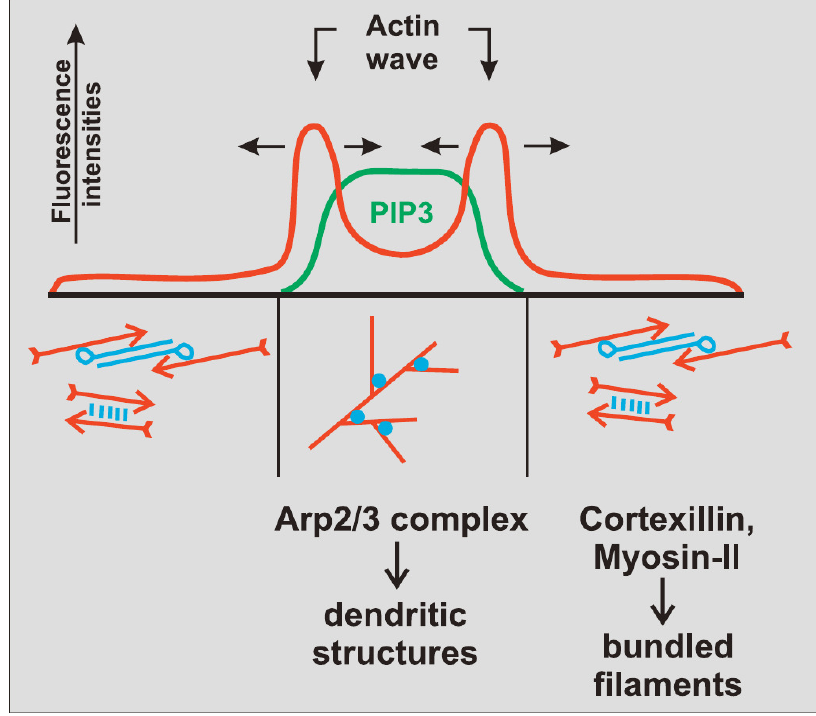
Figure 7. A cross-section of the waves in LatA-treated Dicty cells. From Gerisch